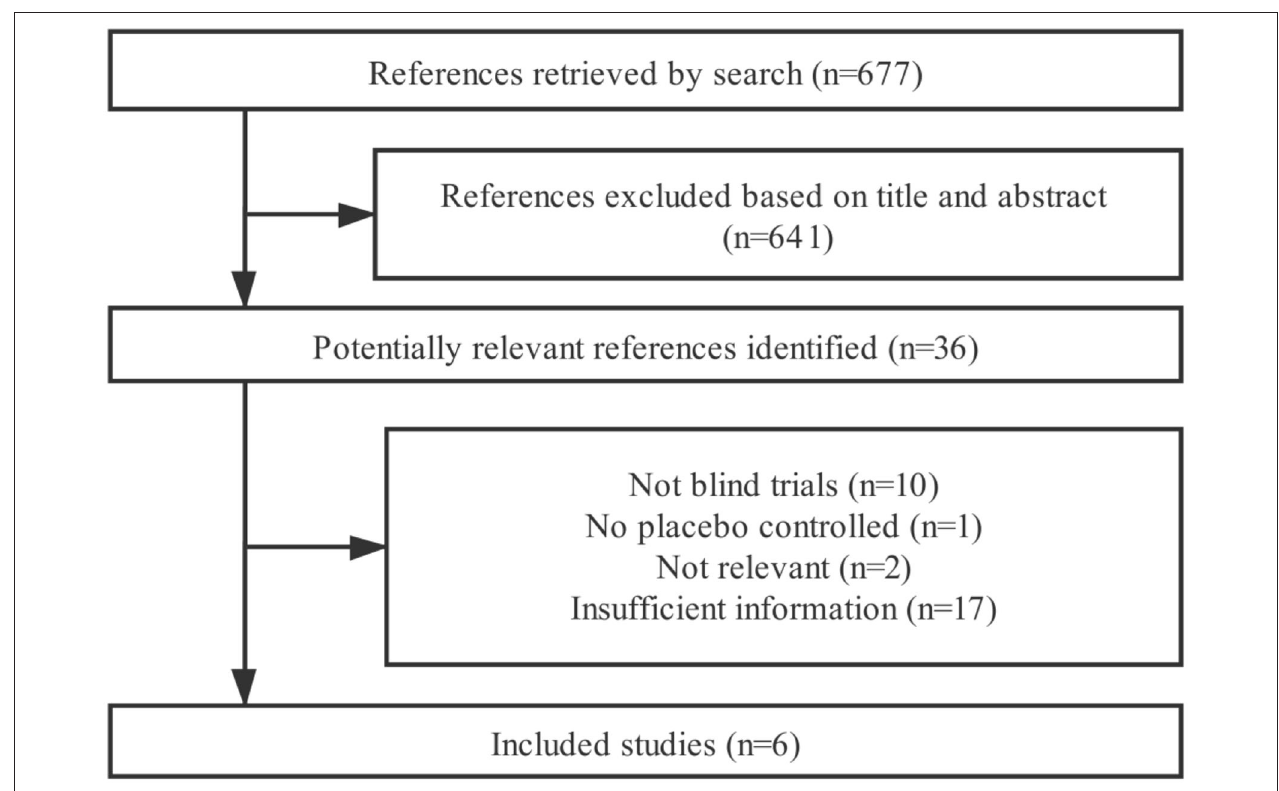
FIGURE 1 | Flow chart of the meta-analysis.